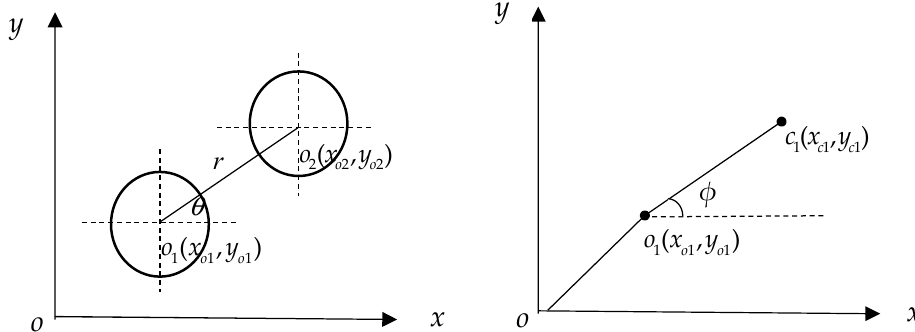
Figure 4. The coordinate relationships of hydro-turbine generator shafting system.